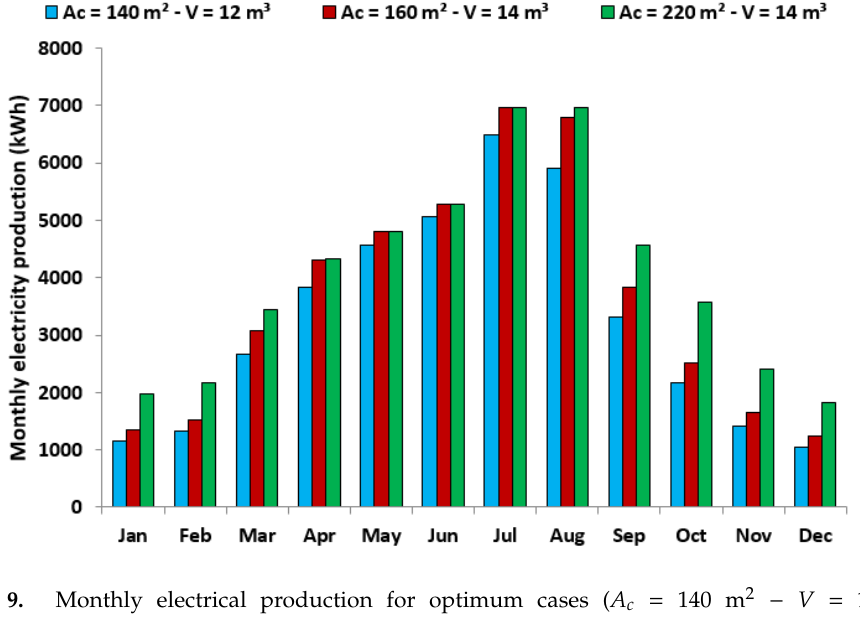
Figure 9. Monthly electrical production for optimum cases ( A c = 140 m 2 – V = 12 m 3 , A c = 160 m 2 – V = 14 m 3 , A c = 220 m 2 – V =14 m 3 ).